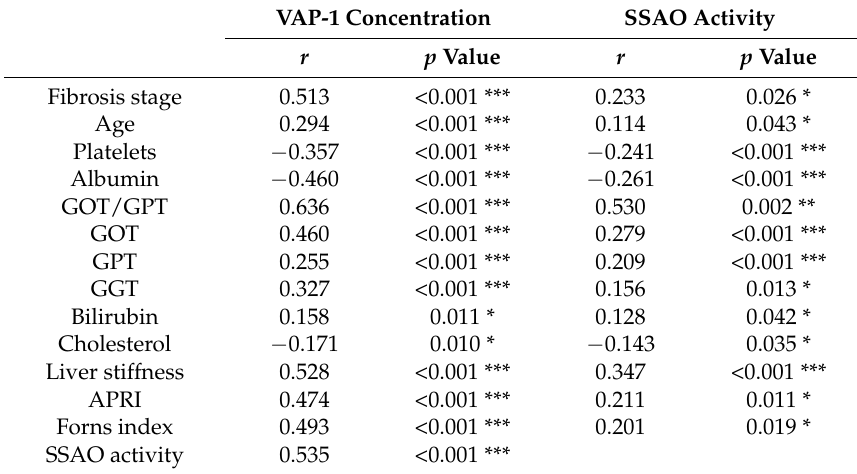
Table 2. Correlation analysis of VAP-1 concentration and semicarbazide-sensitive amino oxidase (SSAO) activity with standard laboratory parameters. Spearman correlating coefficients (r) and p values are shown. Significance is given as * p < 0.05, ** p < 0.01, and *** p < 0.001.